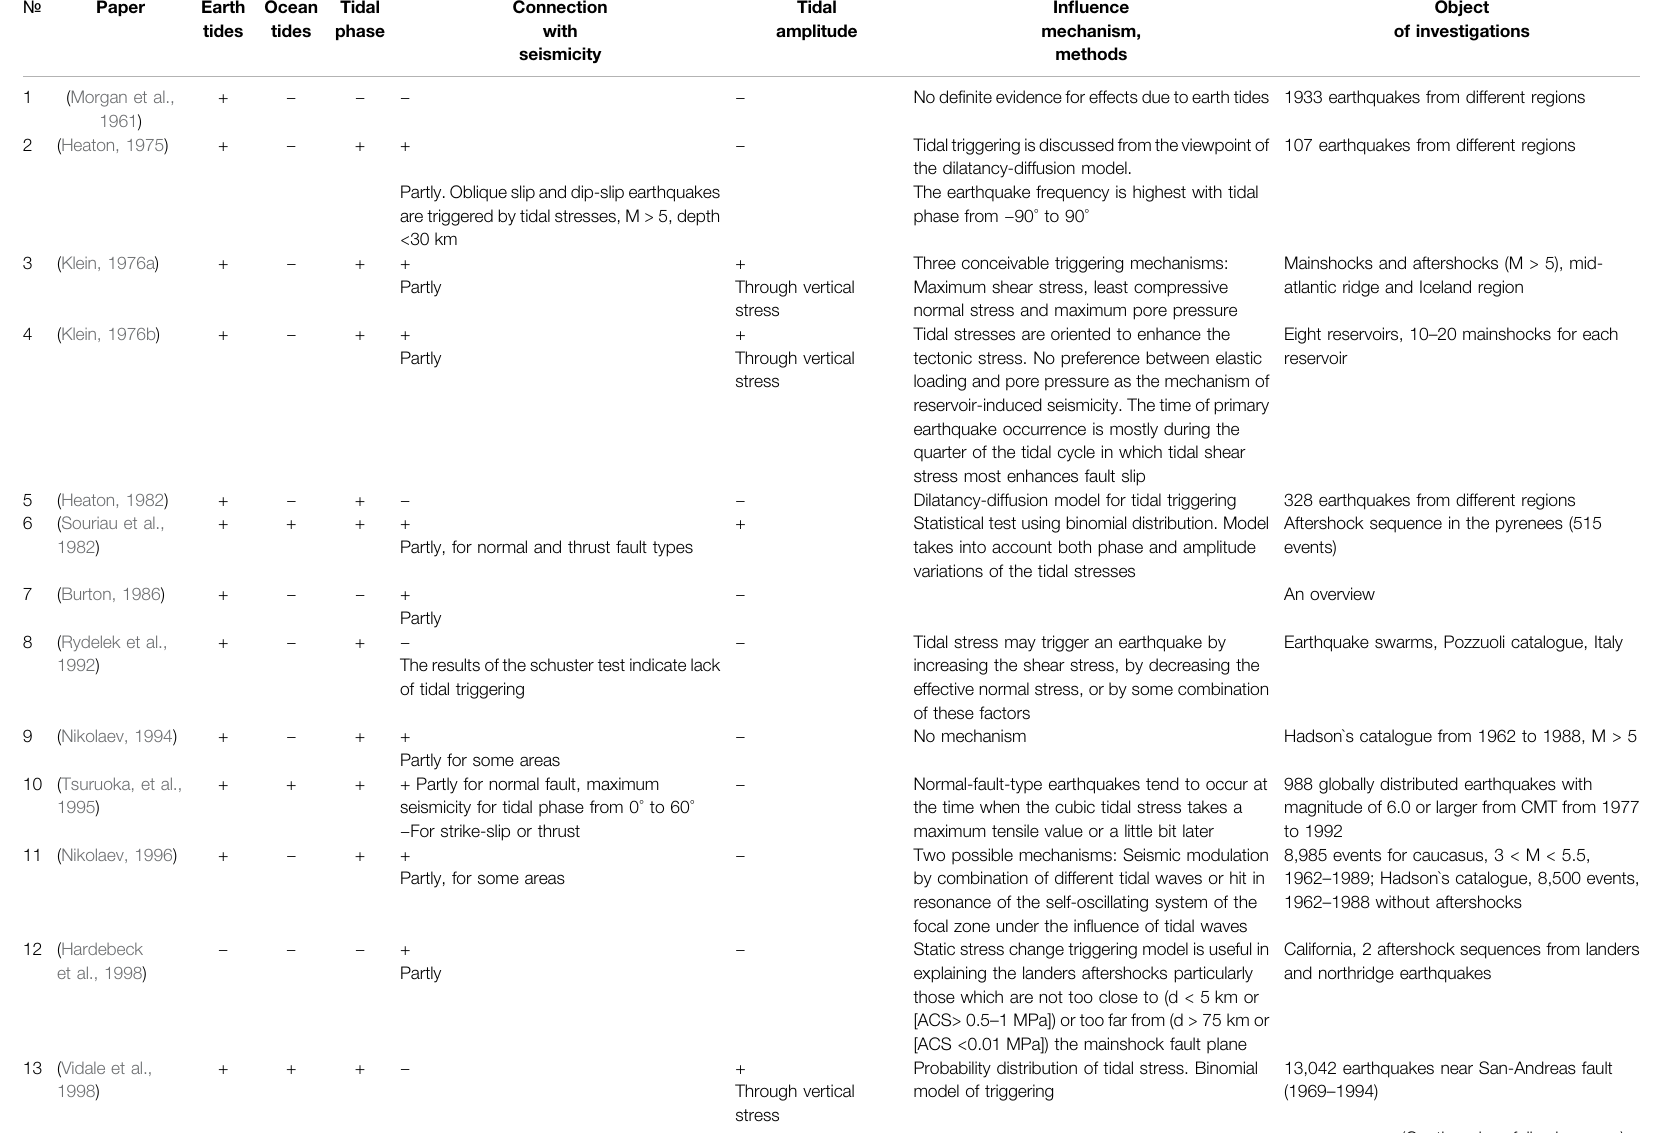
TABLE 1 | A review of studies of the impact of tides on seismicity.